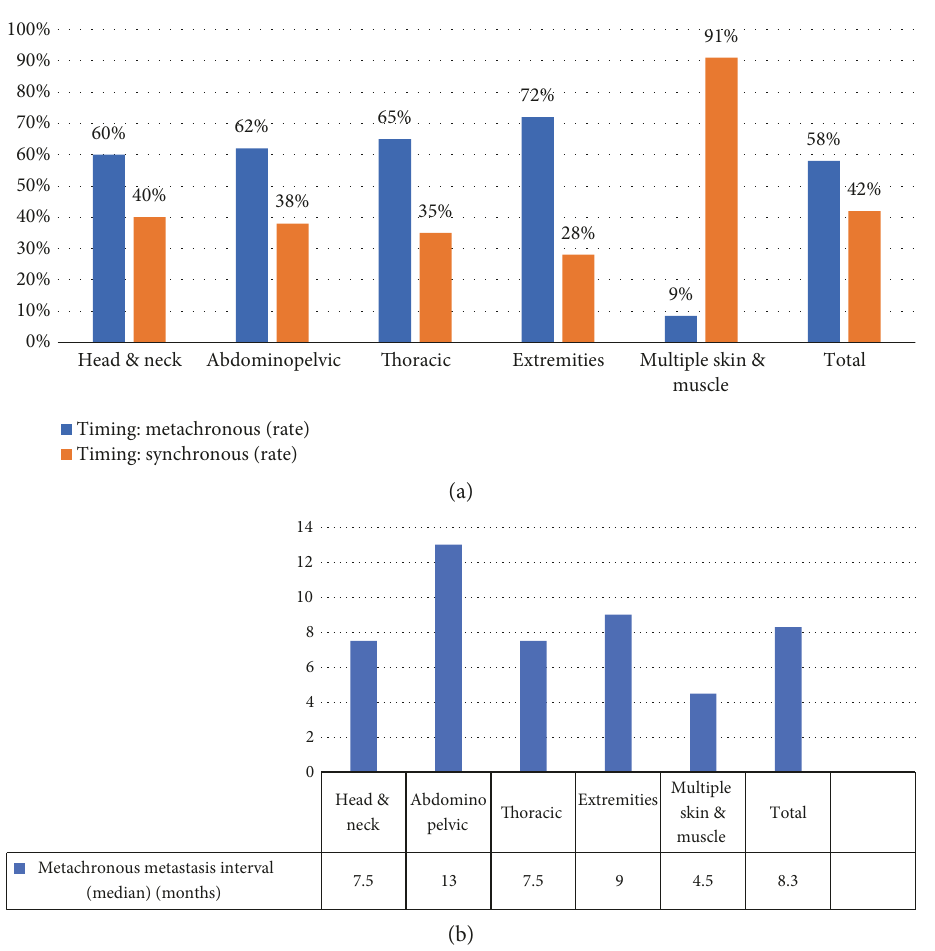
Figure 7: (a) Cancer-metastasis onset (metachronous and synchronous) across ECM anatomical groups. (b) EC and metastasis interval (median and months).